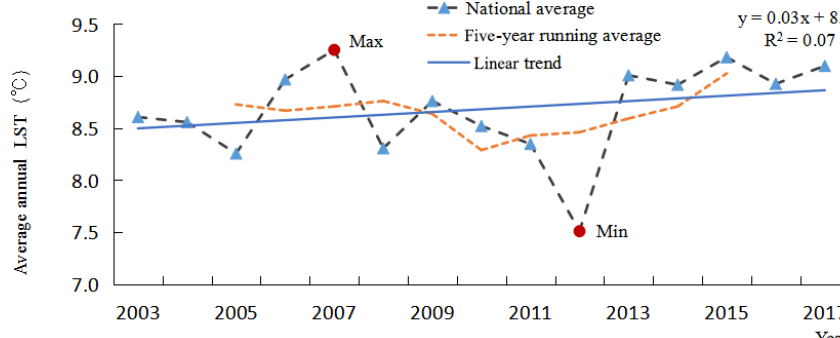
Figure 8. Annual mean LST changes in China from 2003 to 2017.